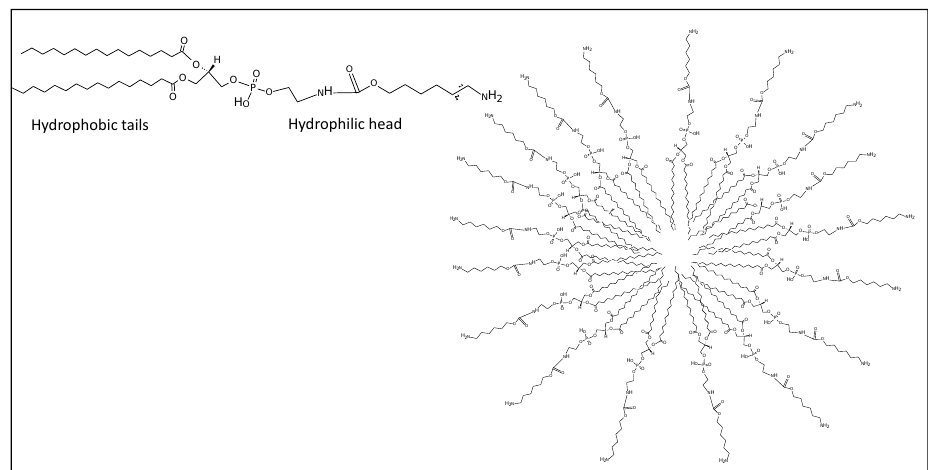
Figure 4. Schematic representation of micelle (right). Chemical structure of PEG-PE (left).